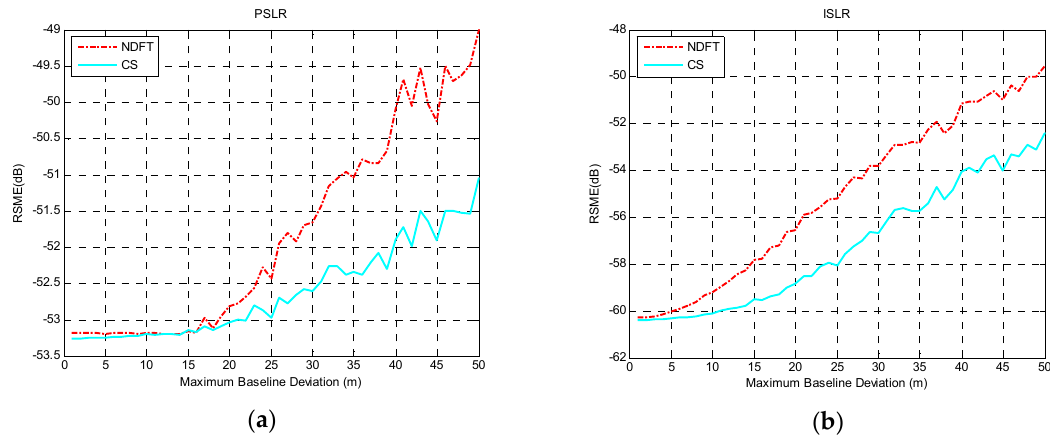
Sensors 2019 , 19 , x FOR PEER REVIEW 11 of 16 Figure 8. The imaging performance with 1000 m